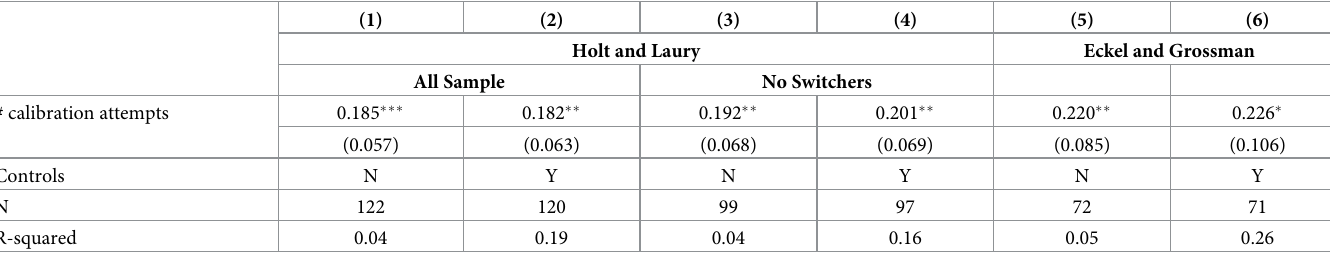
Note. Coefficients from OLS estimations for the treatment groups only are reported. Standard errors are presented in parentheses and clustered at the session level. No switchers removes subjects with inconsistent preferences. Controls include male, age, year in school indicators, race indicators, and categorical family income variables. � Statistically significant at 10% level;